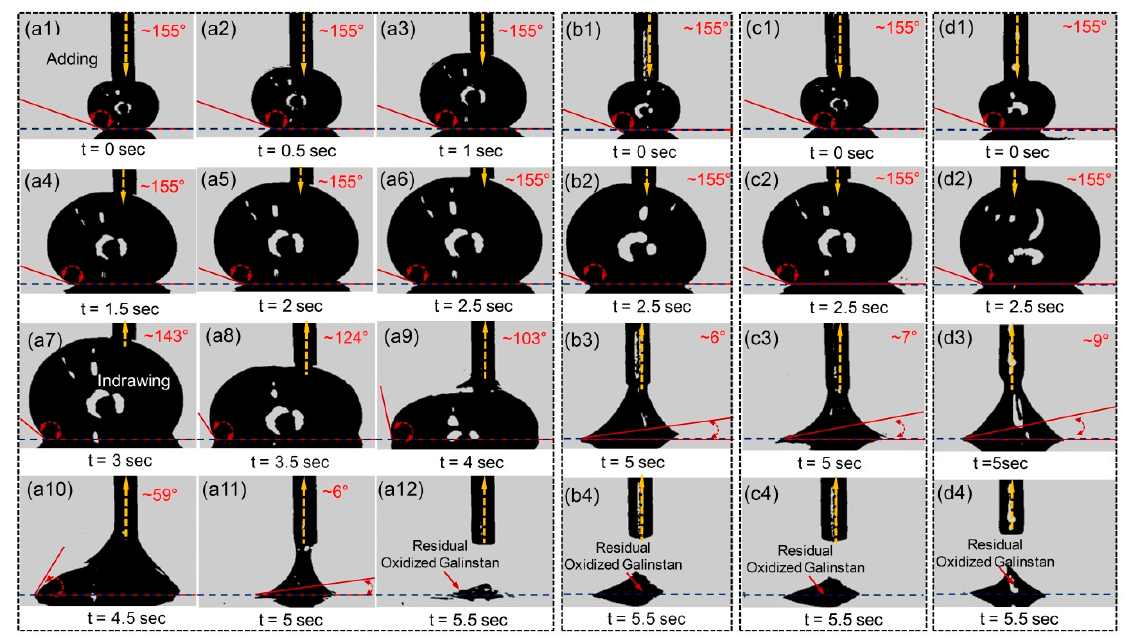
Figure 2. Photographs of advancing and receding angles of the OGD on ( a ) Glass, ( b ) PDMS, ( c ) Au and ( d ) Cu substrate.